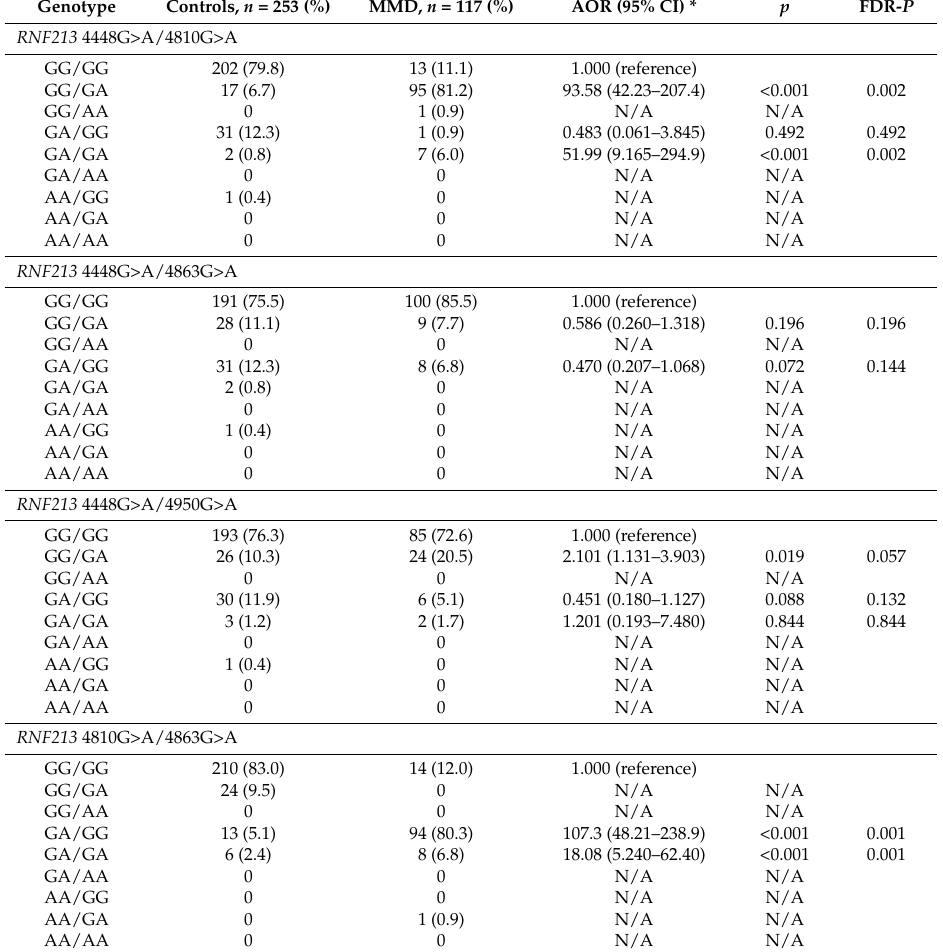
Table 7. Genotype combination frequency of RNF213 in MMD patients and control